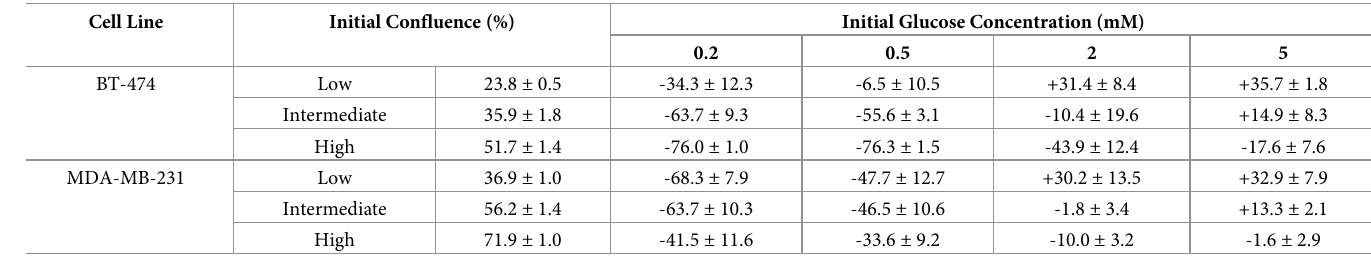
Table 2. Average percent change on the number of live cells from day 0 to day 4. Cell Line Initial Confluence